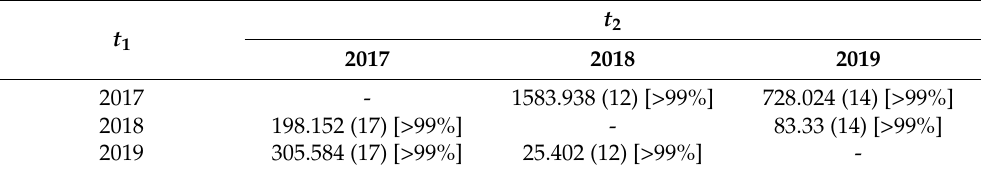
Table 4. Likelihood ratio test results between different periods based on a random parameter approach with heterogeneity in means and variances in helmet-wearing motorcyclists’ crash data ( χ 2 values with degrees of freedom in parenthesis and confidence level in brackets).